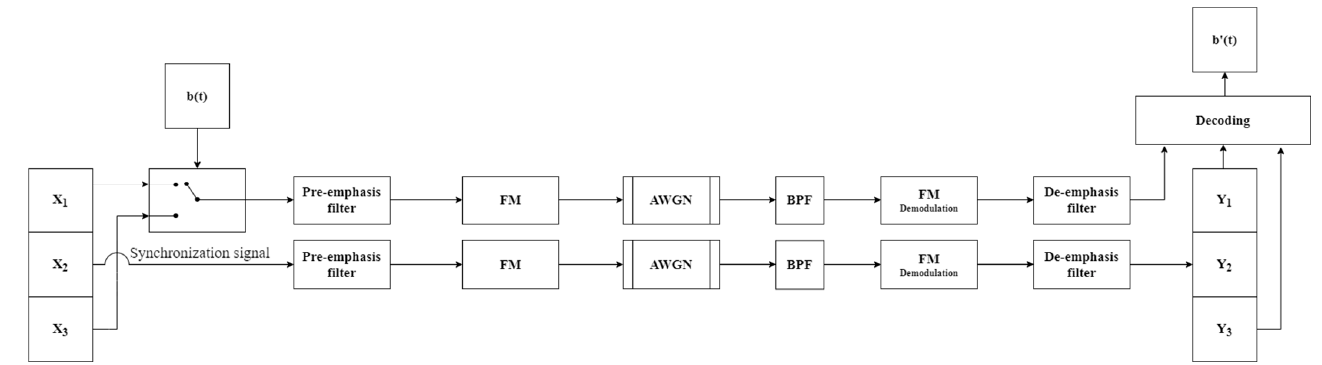
Figure 1. Block diagram of the FM-CSK communication system, where X 1 , X 2 , and X 3 are master oscillator state variables, Y 1 , Y 2 , and Y 3 are slave oscillator state variables, b(t) is binary information signal, FM is frequency modulation, AWGN is additive white Gaussian noise channel, BPF is a bandpass filter, b’(t) is recovered binary information signal.